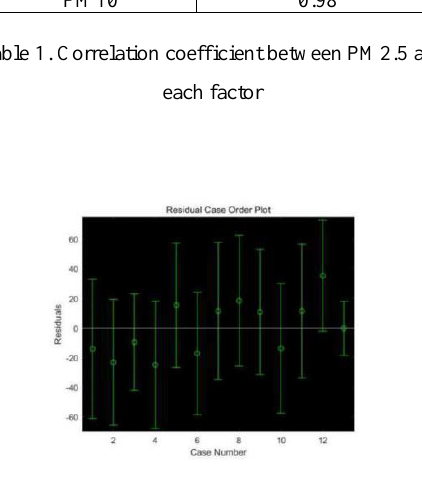
Figure 1.Residual analysis chart